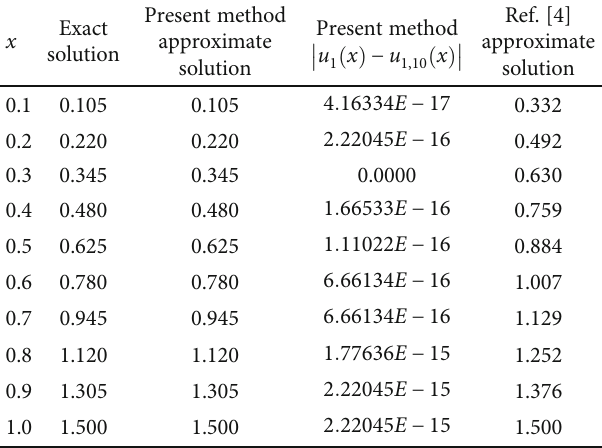
x Þ in Example 3. 1 ð